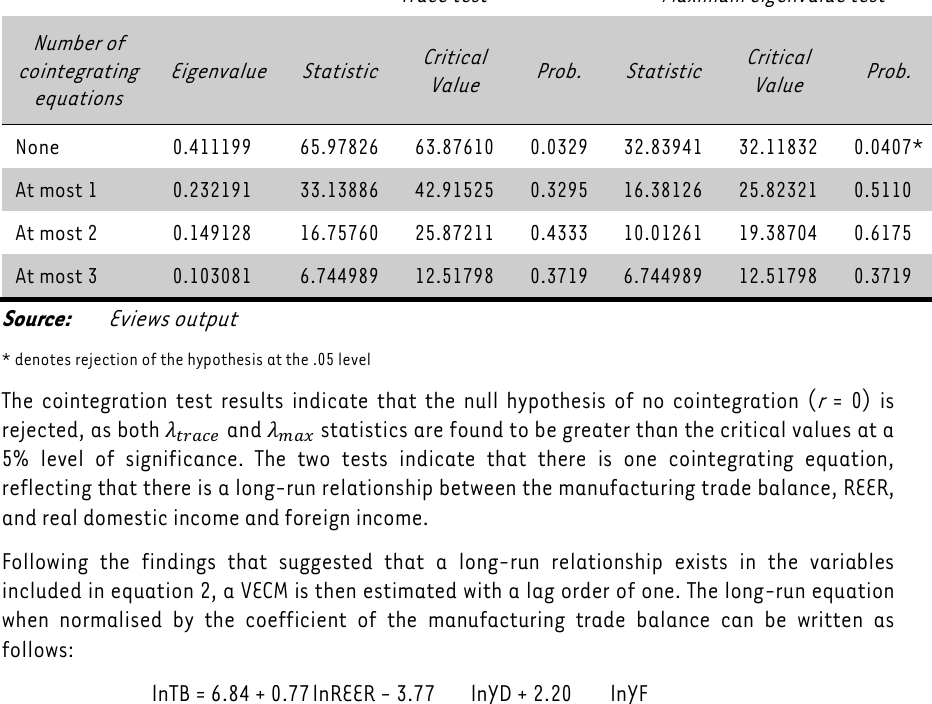
TABLE 2: Johansen cointegration rank test with optimal lag length of one